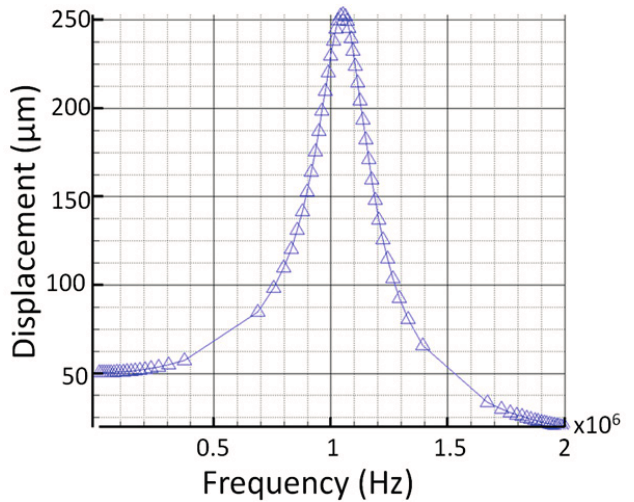
Figure 7. Simulated frequency response of the sensing elements of the proposed